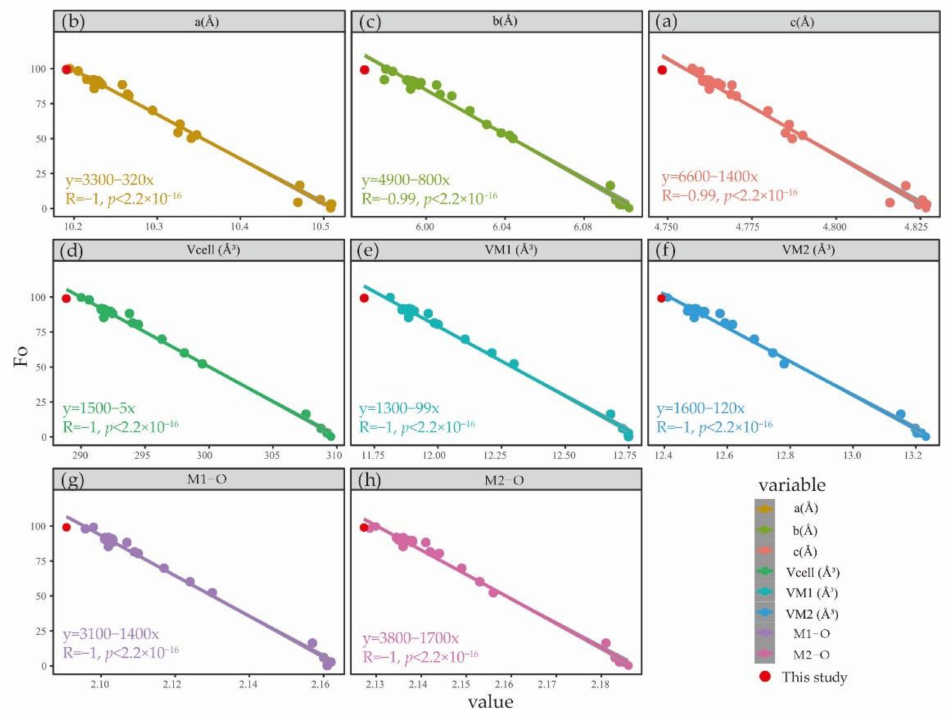
Figure 4. ( a – c ) Unit-cell parameters a , b , c vs. Fo content of olivine. ( d ) Unit-cell volume vs. Fo content of olivine. ( e , f ) The volume of coordination polyhedron M1, and M2 vs. Fo content of olivine. ( g , h ) Average M1–O, and M2–O bond distances vs. Fo content of olivine. Table 4. Assignment of bands in the Raman spectrum of the forsterite. Band (cm − 1 ) Symmetry Assignment B-Rich Olivine (Fo = 99) B-Free Olivine (Fo = 91) 220 A g SiO 4